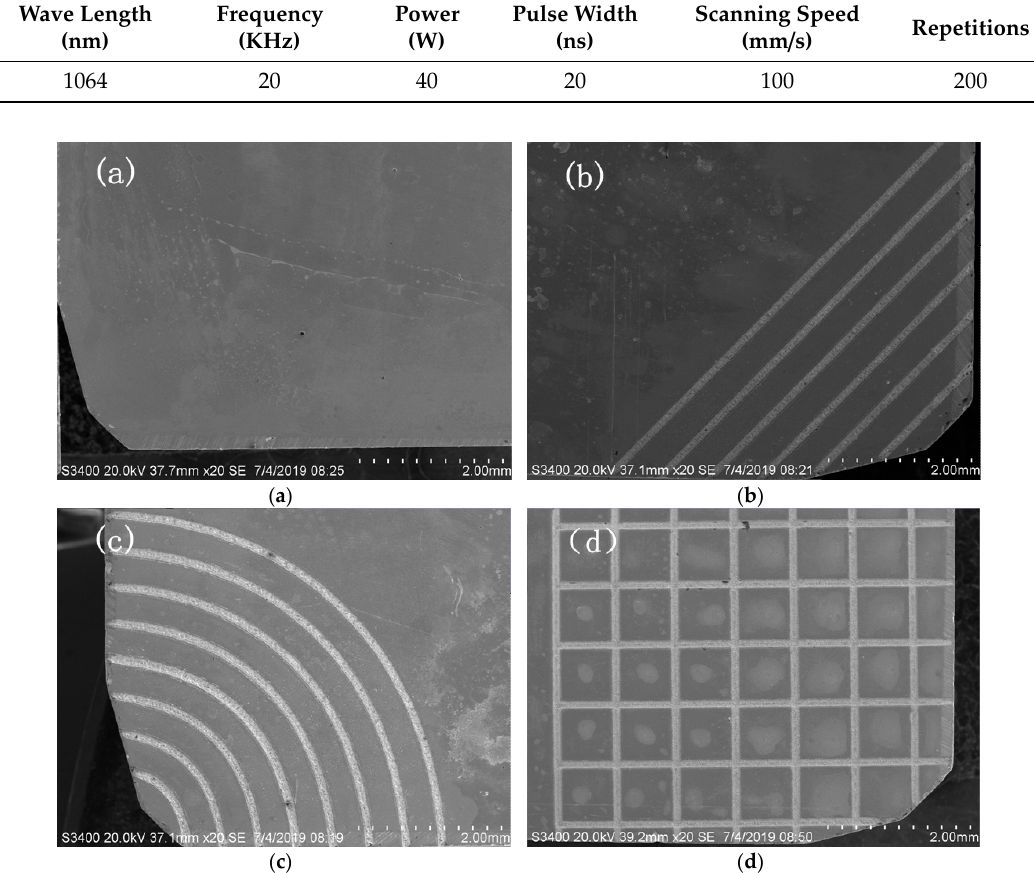
Table 3. Parameters of laser processing.